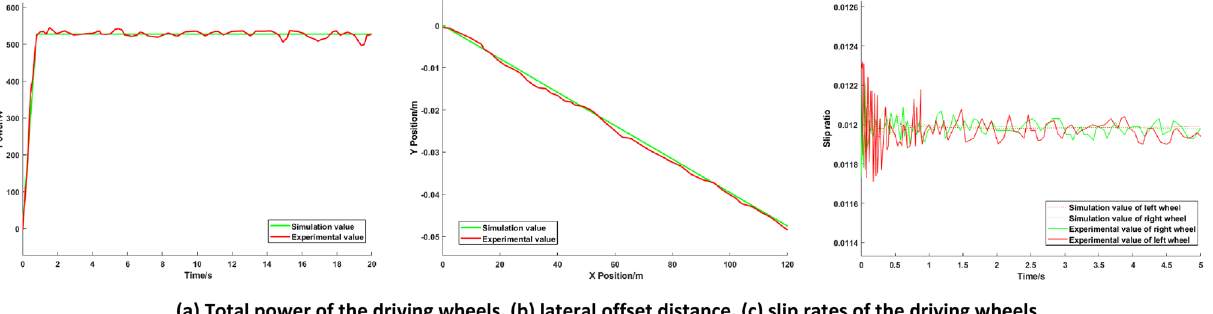
Figure 11. Experimental comparison diagrams of low load conditions.